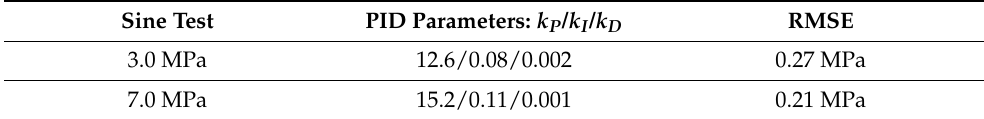
Figure 15. The test results of sinusoidal pressure target tracking of LSVs. The LSVs are controlled with closed-loop PID (Proportional–Integral–Derivative) algorithms to track the sinusoidal pressure target signals. The PID calibration parameters used in the controllers of the OVs and CVs are listed in Table 6, where k P , k I , k D represent the control gains of PID controllers. The RMSE (Root Mean Square Error) values for both channels of wheel cylinders are also summed in the table. Table 6. PID control parameters and hydraulic pressure RMSEs for the